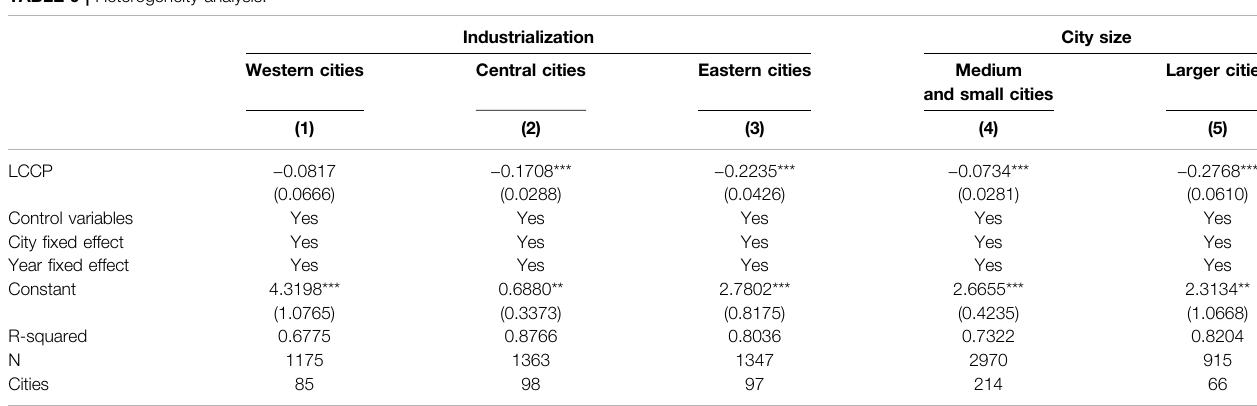
TABLE 9 | Heterogeneity